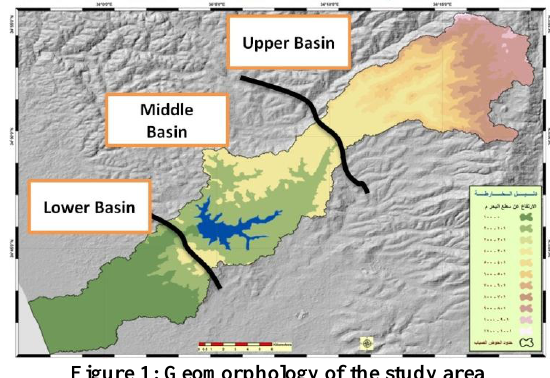
Figure 1: Geomorphology of the study area